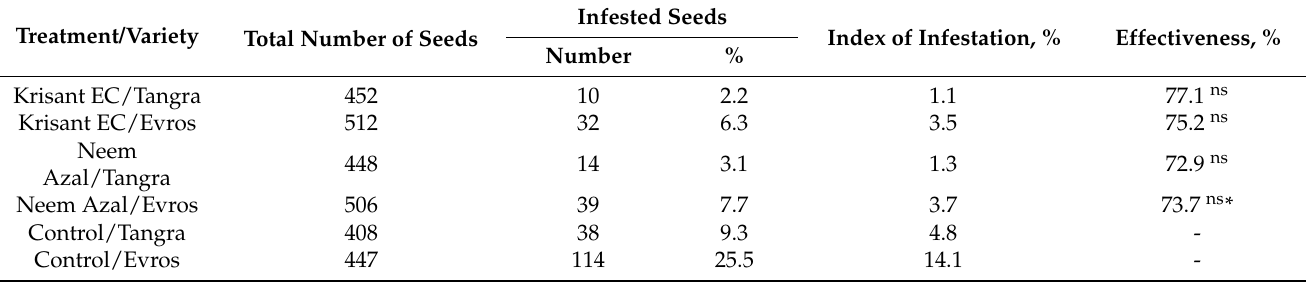
Table 3. Effectiveness of plant protection products against bean weevil ( Acanthoscelides obtectus Say) in two bean varieties, Tangra and Evros, grown in organic field.